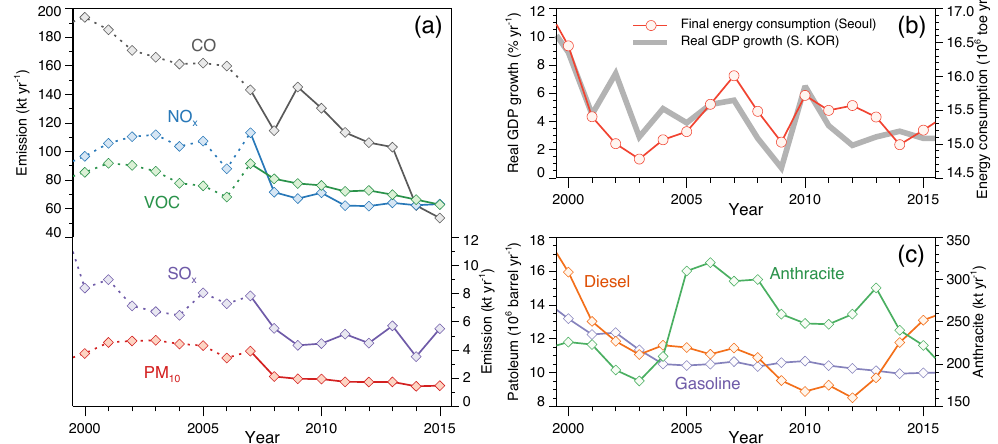
Figure 7. (a) Annual emissions of SO x , NO x , CO, VOCs, and PM 10 in Seoul. Note that the estimation method for the CAPSS inventory has been continuously updated, but the significant update was made in the year 2007. Emissions before and after 2007 were distinguished by dotted and solid lines. (b) Final energy consumption in Seoul and real GDP growth of South Korea. (c) Diesel, gasoline, and anthracite consumptions in